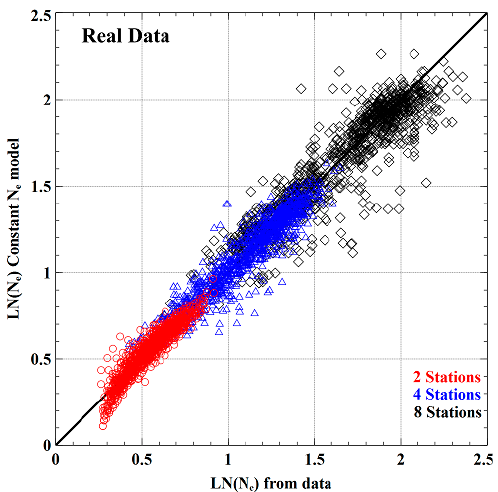
Figure 4. Comparison of directly computed N e from the annual maximum flood series (AMFS) data and N e by the constant N e model. The black line represents a 1:1 line. and N e by the constant N e model. The black line represents a 1:1 line.